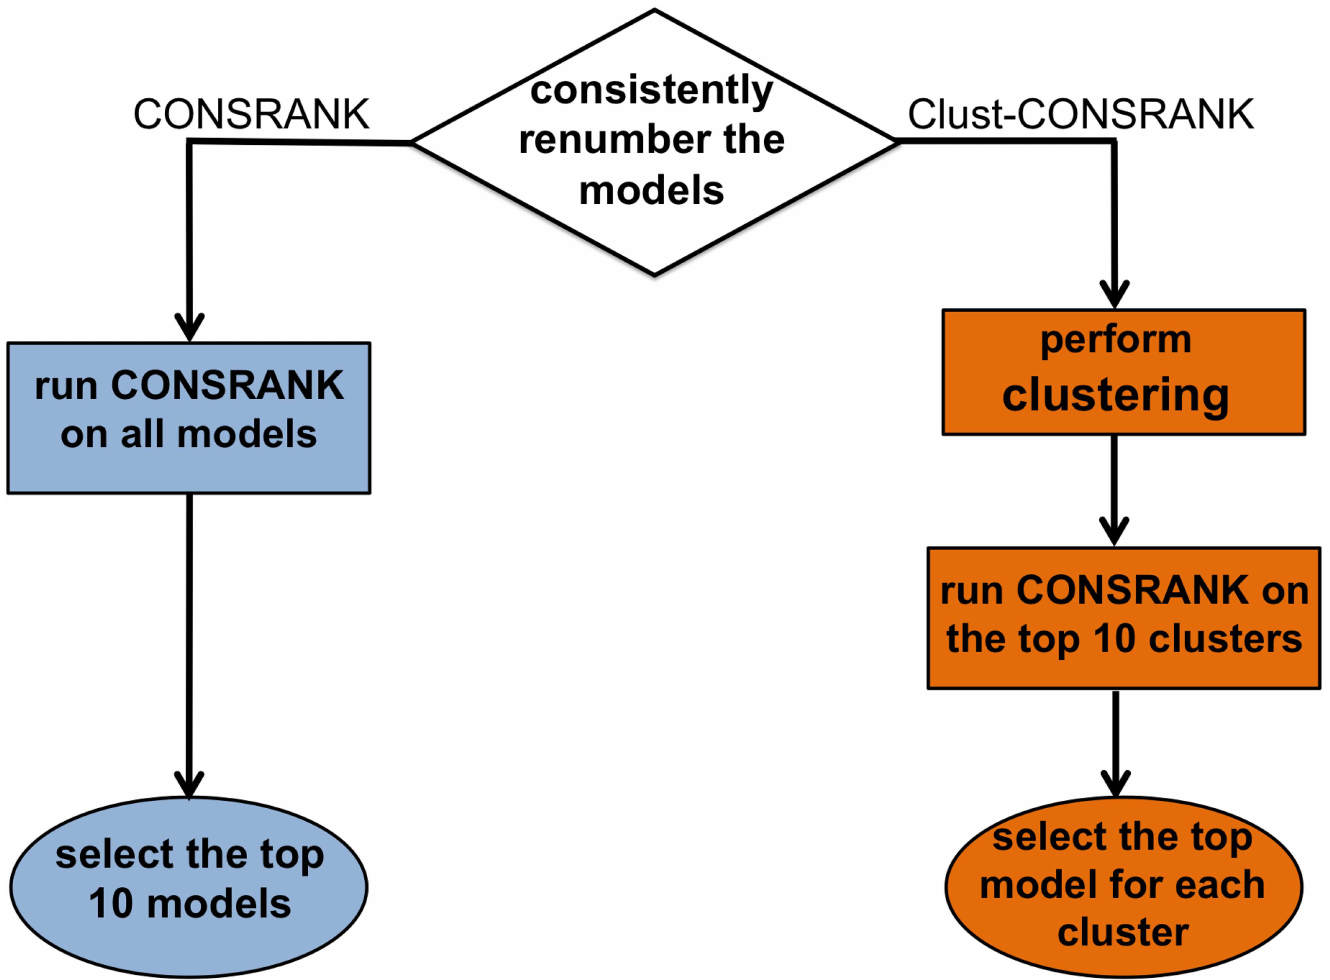
Fig 1. Schematic representation of the CONSRANKand Clust-CONSRANK workflow.